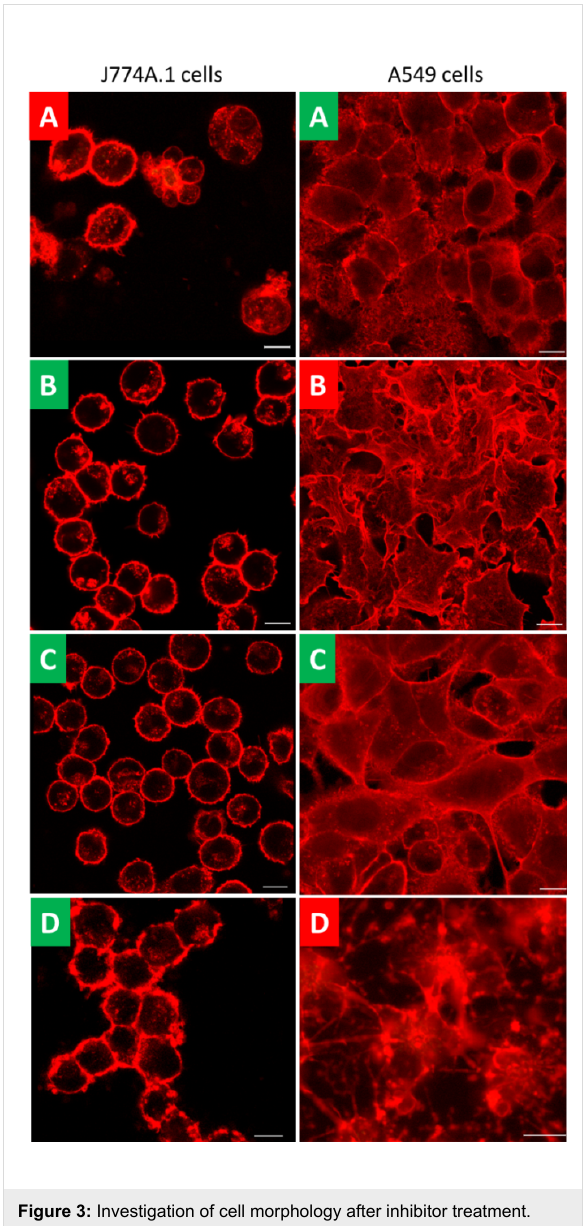
Figure 3: Investigation of cell morphology after inhibitor treatment. Healthy cells (green inset) retained their cellular structure after inhibitor treatment. Impaired cells (red inset) showed membrane damage, loss of integrity and loss of viability. (A) chlorpromazine, (B) monodansylca- daverine, (C) m β cd, and (D) cytochalasin D. Scale bar: 10